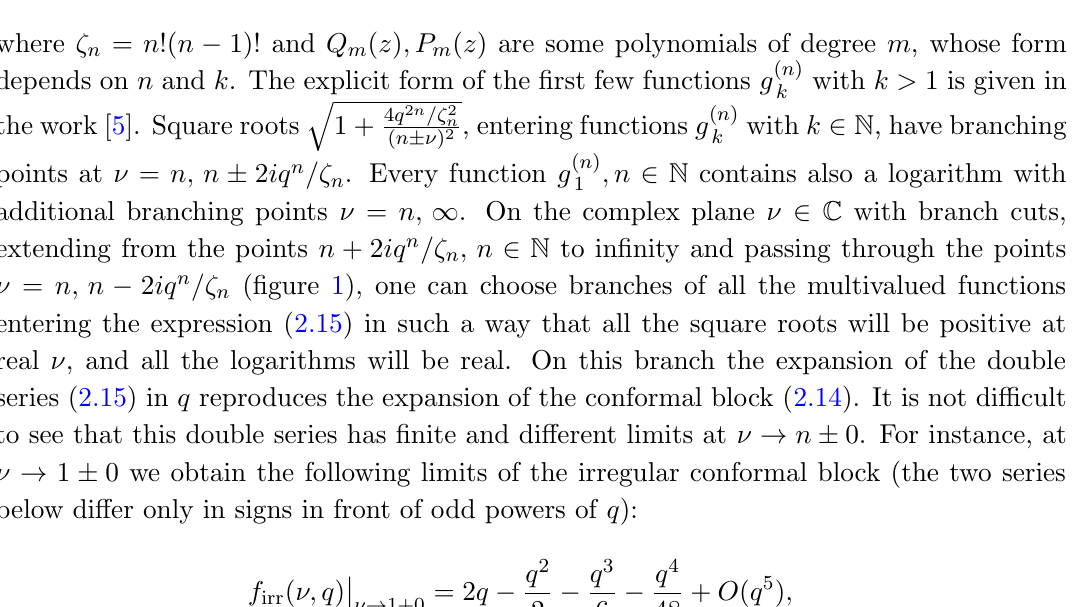
Figure 1 . Branching points of the functions g ( n ) irregular conformal block f irr ( (cid:23); q ), on the plane of intermediate dimensions (cid:23) . Branch cuts are depicted as wavy